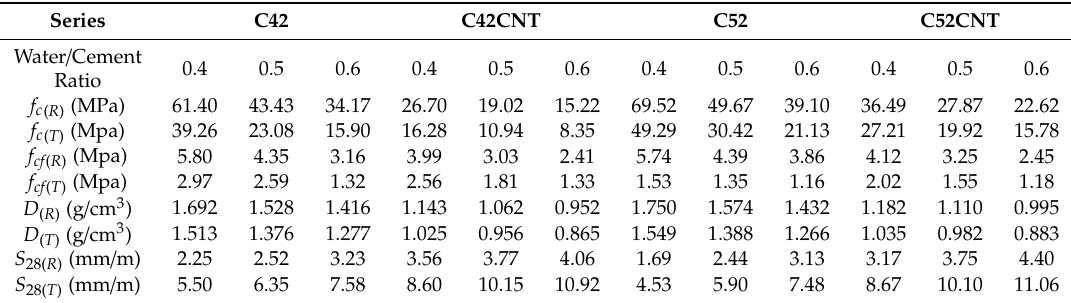
Table 1. The results of the physico-mechanical characteristics of the cement pastes